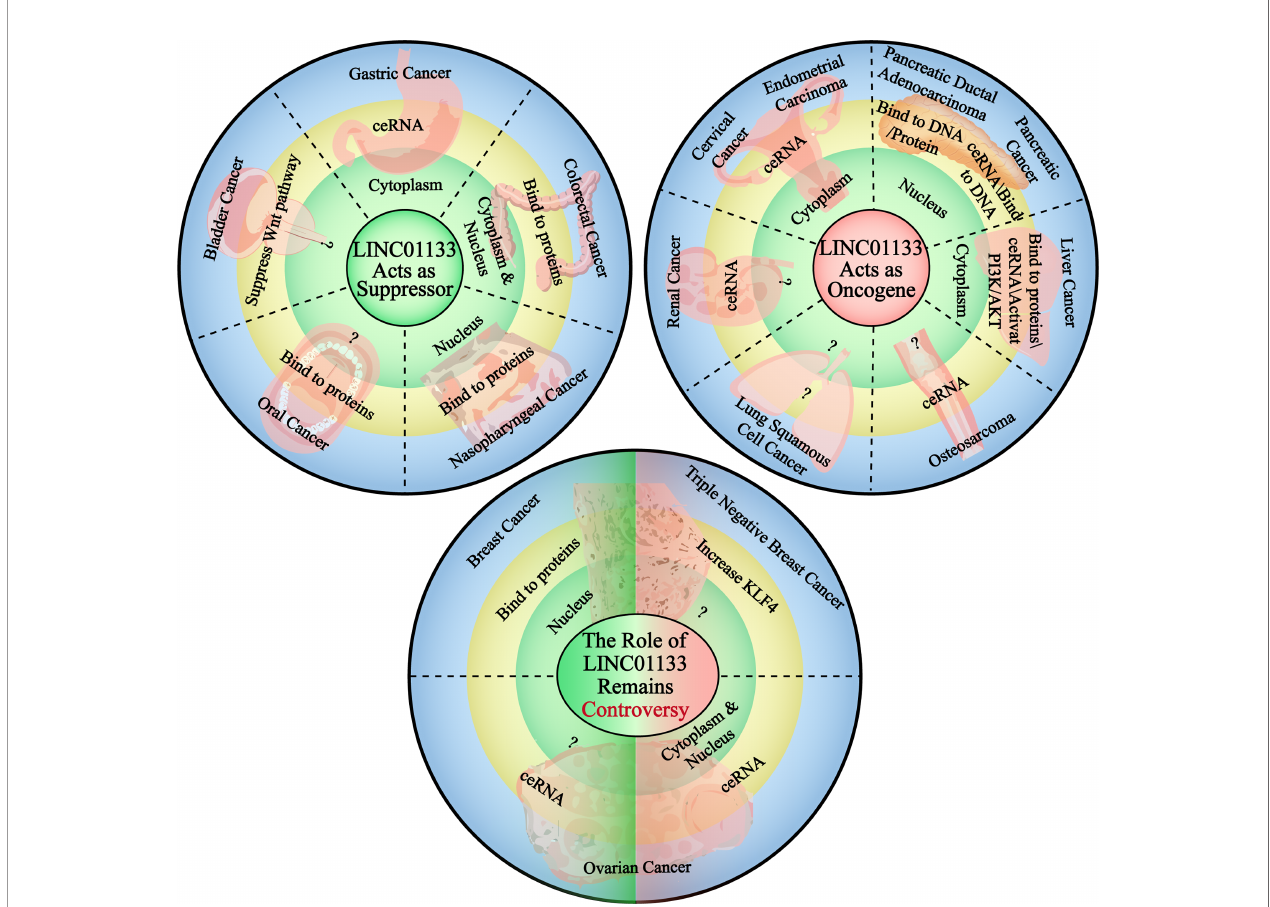
FIGURE 4 | The carcinogenetic or suppressing role of LINC01133 in the cancers of different tissue type. The circle in the upper left corner demonstrates the cancers in which LINC01133 acts as a cancer suppressor, the subcellular localization of LINC01133 in each type of cancer and the main mechanism of it to function. The circle in the upper right corner demonstrates the cancers in which LINC01133 acts as an oncogene, and also the subcellular localization and functional mechanisms. The circle lower in the middle states the cancers in which the role of LINC01133 is still controversy. The green left side represents the suppressor role of LINC01133, the localization and functional mechanisms, and the red right side represents the oncogene role of LINC01133, the localization and functional mechanisms. The black dashed lines separate the cancers of different tissue